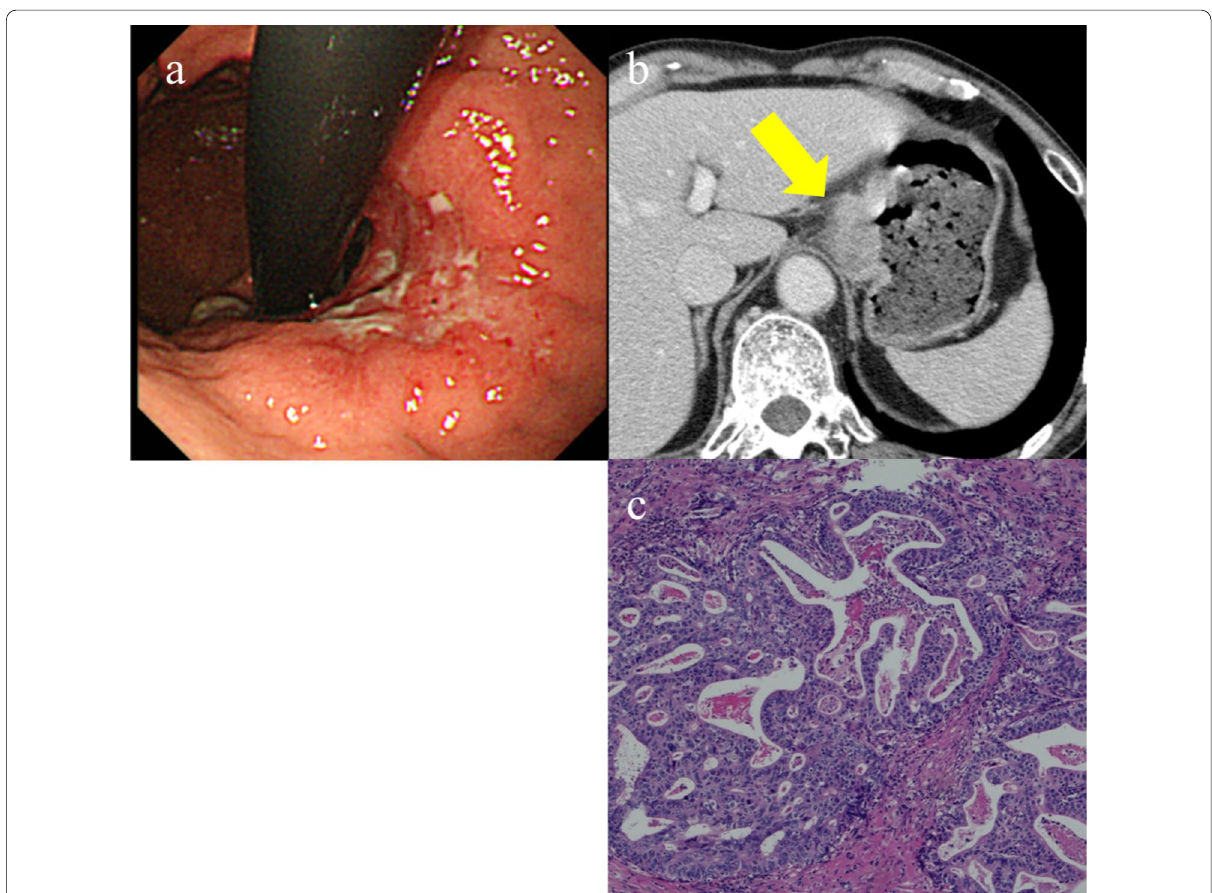
Fig. 2 Computed tomography (CT) scan and pathological findings of the primary gastric cancer. a Upper endoscopy demonstrated circumferential ulcerated lesion at the cardia. b CT scan showing wall thickening at the lesser curvature side of the upper gastric body. c Pathological examination reveals a moderately differentiated